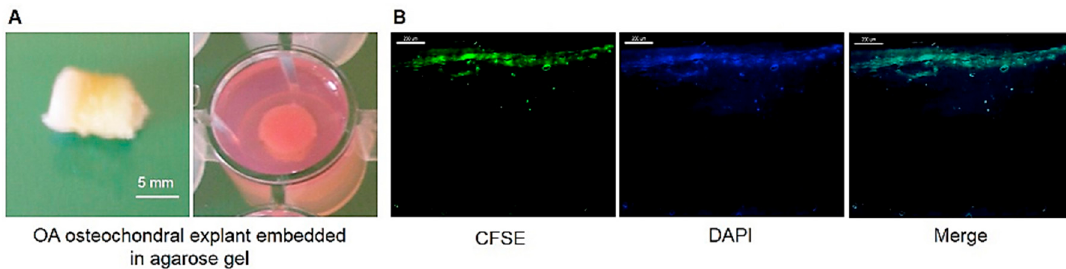
Figure 3. ( A ) Representative macroscopic image of the OA osteochondral explant; and ( B ) a representative fluorescence photomicrograph of cryo-sections showing attachment and proliferation of CFSE-labelled hBMSCs on the surface of OA explant on day 21 of co-culture. hBMSCs are indicated by green fluorescence and cell nuclei are stained with DAPI (blue). Scale bar represents 200 µm.